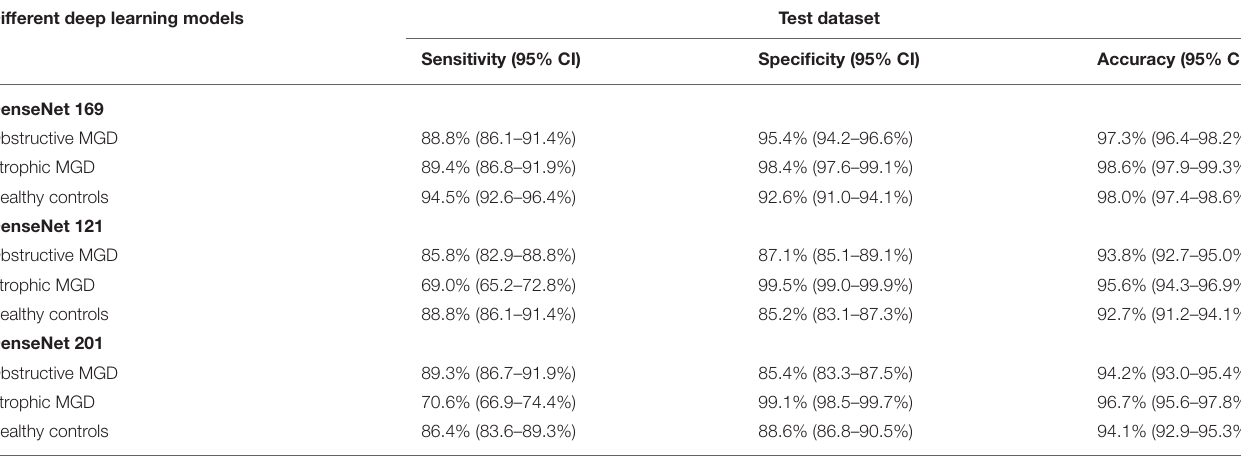
TABLE 1 | Performance of three deep learning algorithms in the test